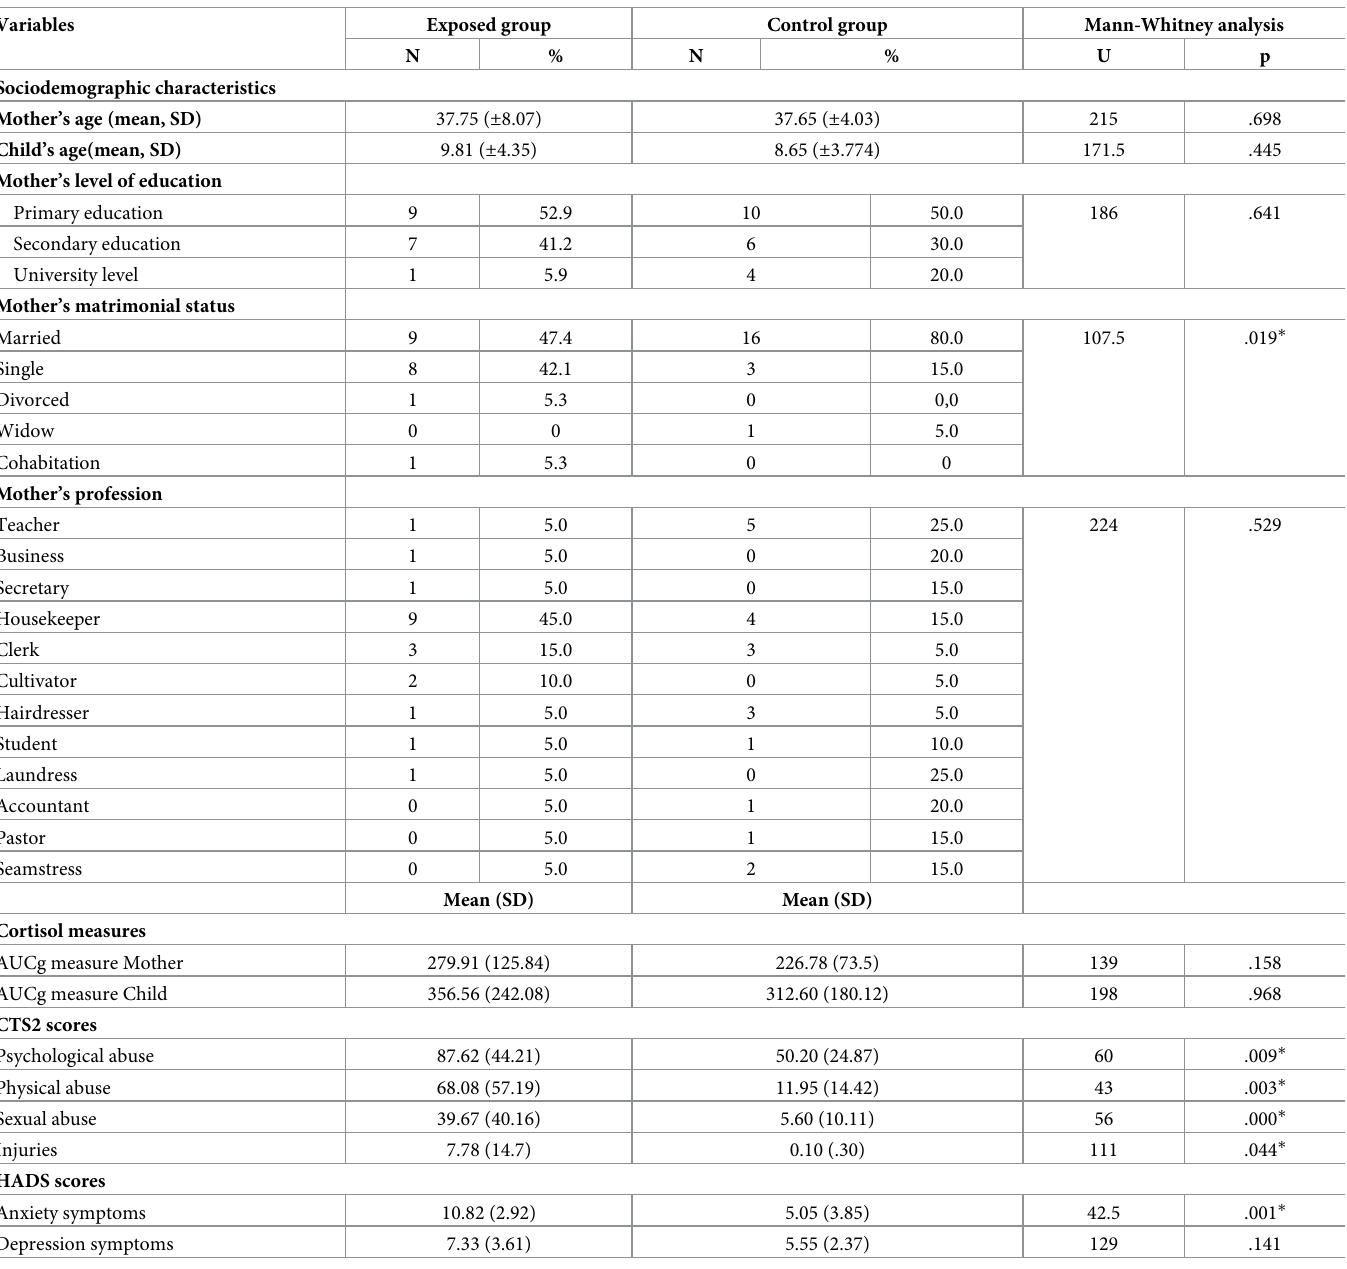
Table 1. Sociodemographic characteristics, cortisol measures, CTS and HADS scores of participants.